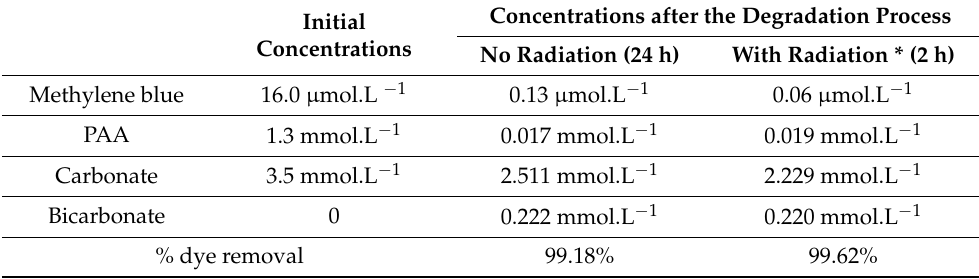
Table 2. Results of the dye degradation assay showing the concentrations of degraded dye and residual